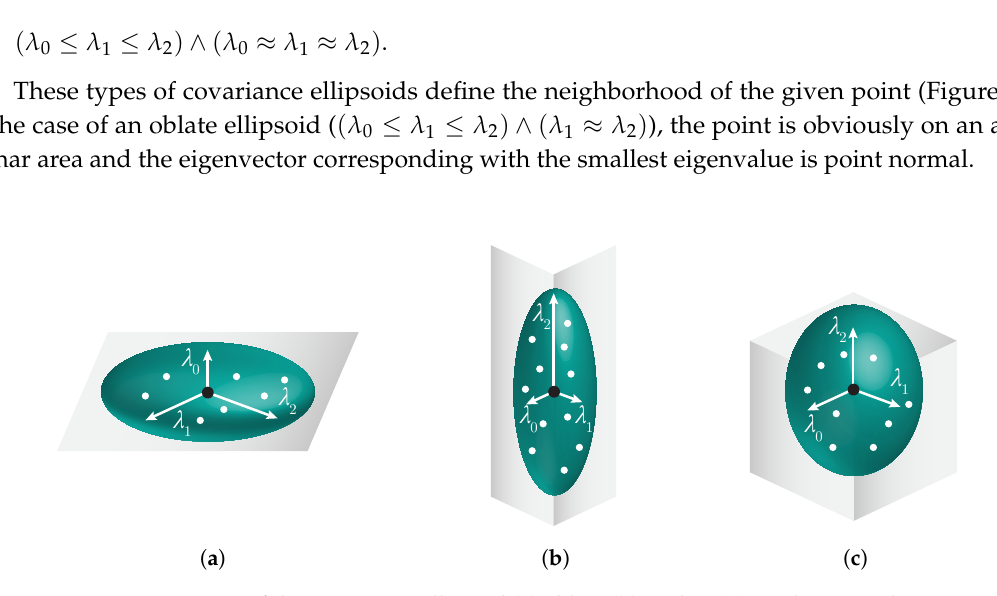
Figure 3. Types of the covariance ellipsoid ( a ) oblate ( b ) prolate ( c ) similar to a sphere.